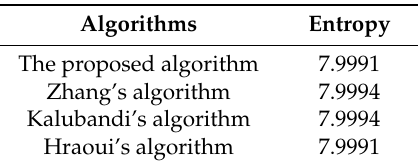
Table 5. Entropy values.